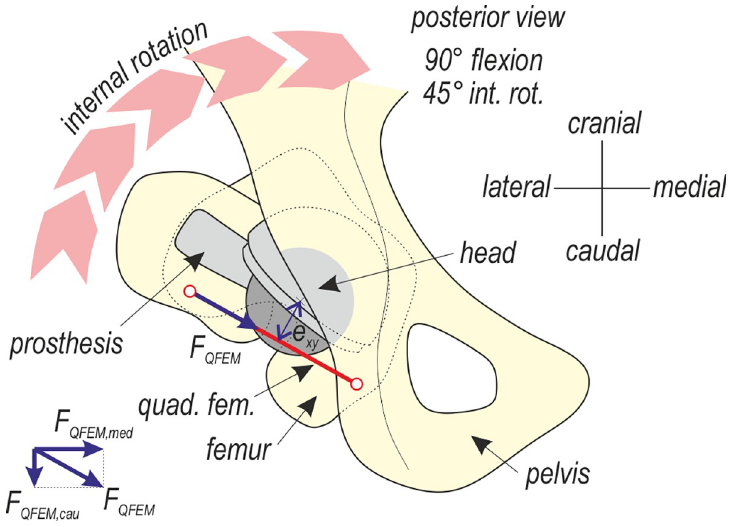
Fig 7. Posterior view of the quadratus femoris during the intraoperative manoeuvre.